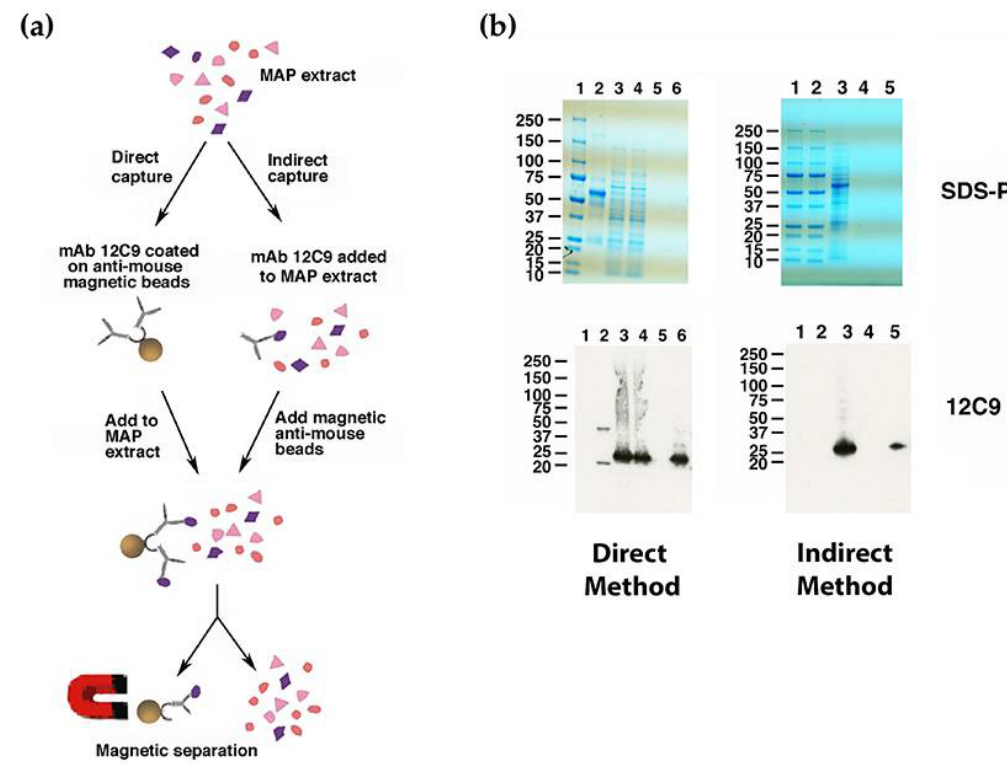
Figure 3. Direct and indirect capture of the Map antigen that binds mAb 12C9. Shown is a schematic flow diagram of the two methods ( a ). The primary difference between these methods is that the mAb is bound to the magnetic beads before exposure to the antigen extract versus afterwards as in the indirect method. The brown sphere is the magnetic bead. Both methods were analyzed by SDS-PAGE and immunoblot analysis ( b ). Shown are stained sodium dodecyl sulfate–polyacrylamide gel electrophoresis (SDS-PAGE) gels (top) and corresponding immunoblots probed with 12C9 (bottom) for the direct (left) and indirect (right) capture experiments. The 12C9 probed blots show that the antigen was captured while the anti-mouse control had no reactivity suggesting that the capture was specific. Lanes for the direct method are: 1 = Protein size markers, 2 = bead coupled 12C9 antibody, 3 = K-10 antigen before capture, 4 = K-10 antigen after capture with 12C9 magnetic beads, 5 = combined washes, and 6 = antigen eluted from magnetic beads. Lanes for the indirect method are: 1 and 2 = Protein size standards, 3 = K-10 antigen mixed with 12C9 antibody, 4 = combined washes after incubation, and 5 = antigen eluted from magnetic beads.